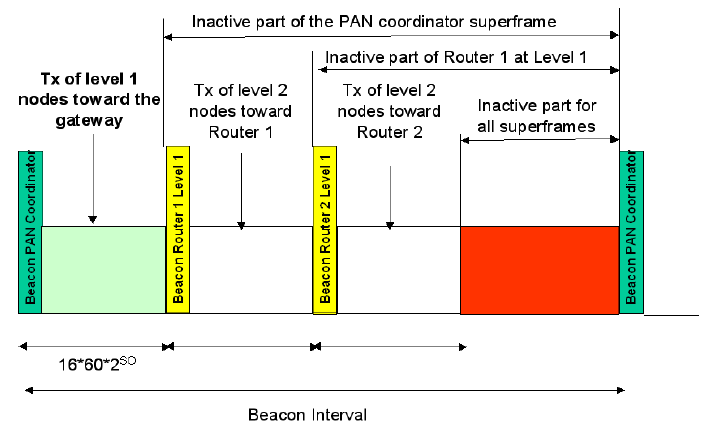
Figure 10. The superframe structure used in the tree-based